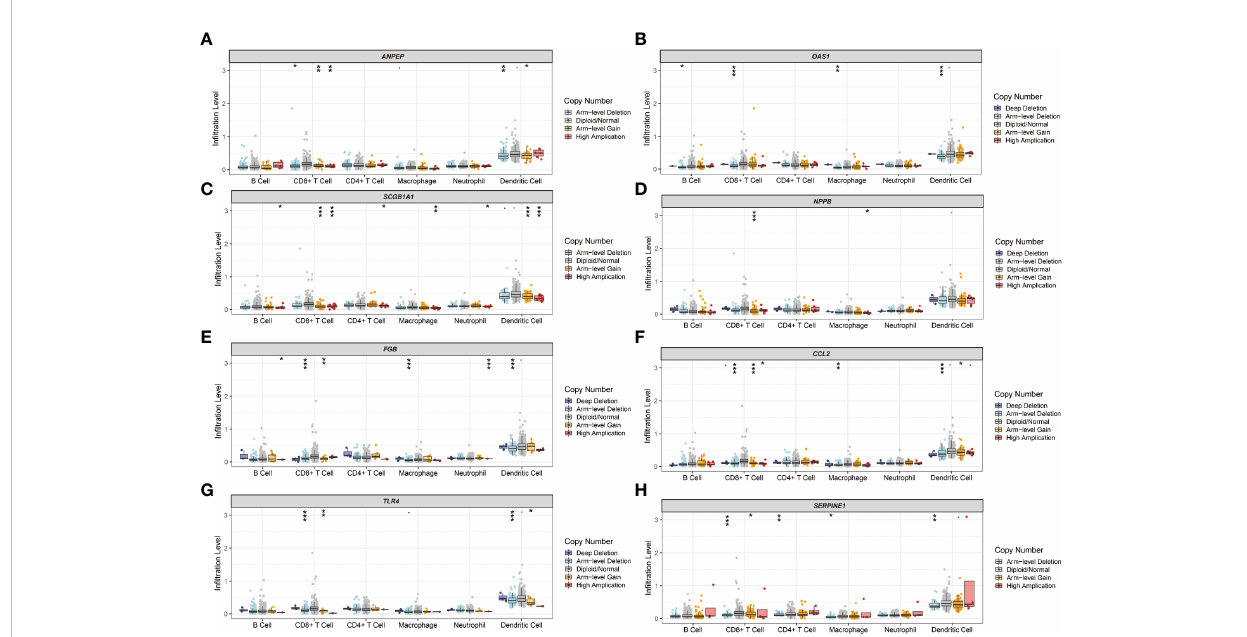
FIGURE 11 Immune cell in fi ltration in fl uenced by copy number variation of prognostic genes. (A) ANPEP , (B) OAS1 , (C) SCGB1A1 , (D) NPPB , (E) FGB , (F) CCL2 , (G) TLR4 , and (H) SERPINE1 .